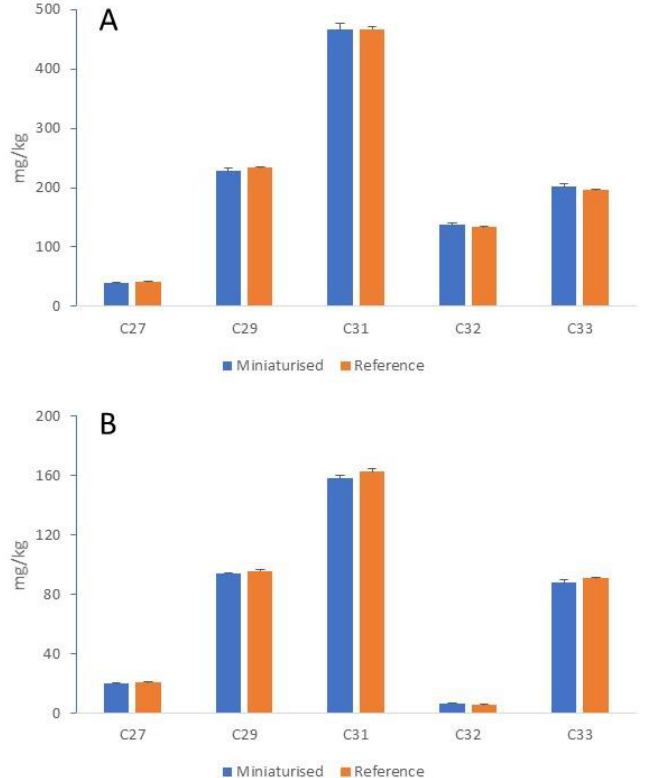
Figure 3. Comparison of alkane measurement results obtained by the miniaturised protocol and the reference method. Each column is the mean of three technical replicates and error bars are standard deviations (SD). ( A ): faeces; ( B ): herbage. Note: no significant difference was found for any n -alkane between the two methods (statistical symbols omitted).